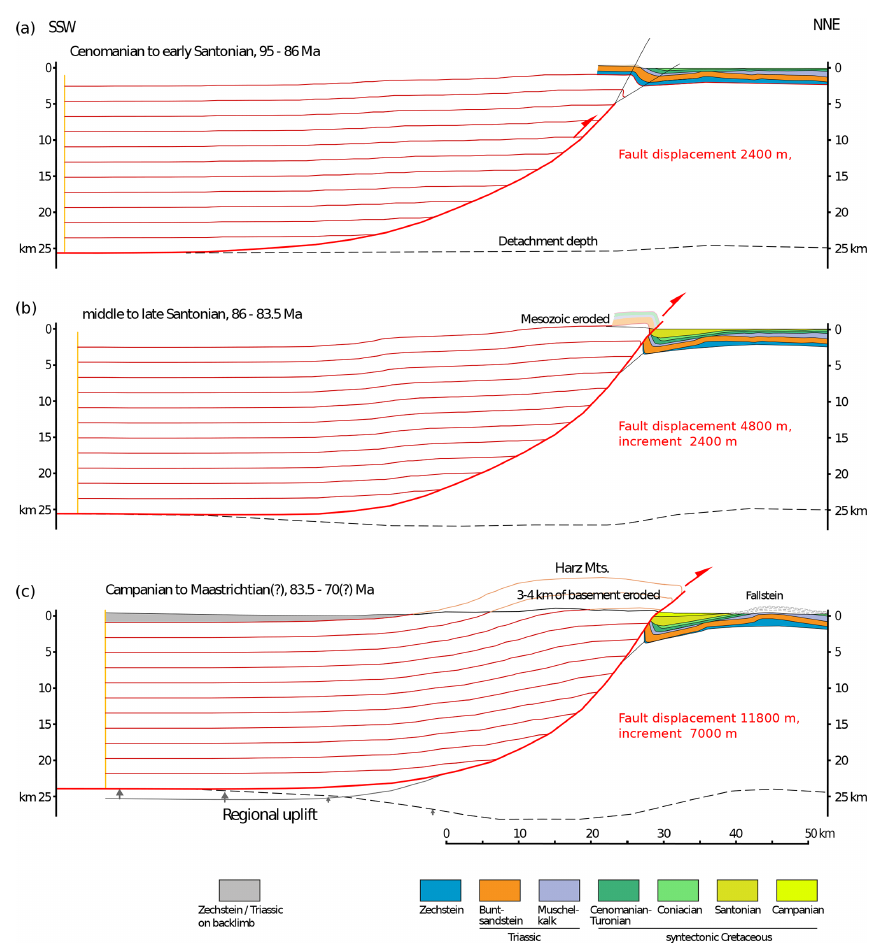
Figure 5. Three-stage geometric model of the Harz basement uplift. A listric thrust dipping 50 ◦ near the surface and reaching 25km of depth creates the Harz anticline with a reasonable exhumation depth (constrained by thermochronological data) after 12000m of total displacement. Red marker lines illustrate the gentle deformation of the hanging wall block. The cross-sectional geometry of the Subhercynian Basin and Fallstein salt anticline is from Voigt et al. (2008) (their Sects. E–F). The evolution of the gentle northern flank and Fallstein anticline was obtained by reversing a stepwise restoration of the cross section. (a) The growing Harz anticline is modelled using a trishear triangle with its apex fixed to the footwall and a trishear angle of 30 ◦ (thin black lines). (b, c) The steep limb of the footwall syncline is further modelled with a trishear angle decreasing to 25 ◦ and then 20 ◦ . The hanging wall in these steps requires more displacement than predicted by the trishear algorithm to satisfy the indicated exhumation